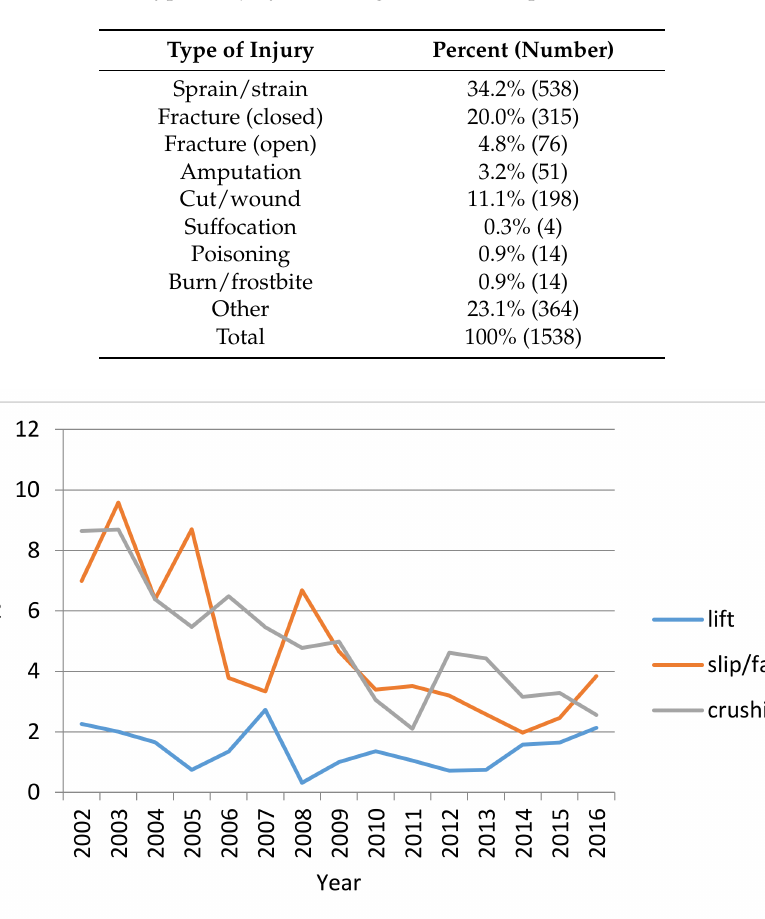
Table 7. Type of injury on fishing vessels in the period 1998–2016.